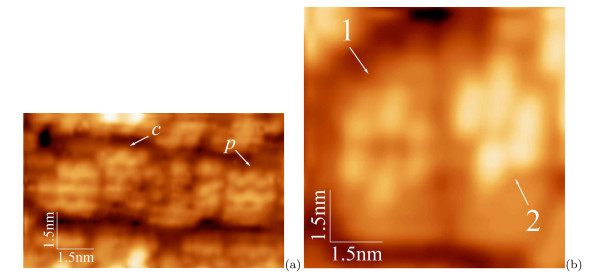
STM images of Ge WL on Si(001): (a) c(4 × 2) (c) and p(2 × 2) (p) reconstructions within the (M × N) patches, hGe = 6.0 Å, Us = +1.80 V, It = 80 pA; (b) new formations arise on the (M × N) patches due to nucleation of Ge pyramid (1) and wedge (2), hGe = 6,0 Å, Us = +2.60 V, It = 80 pA.